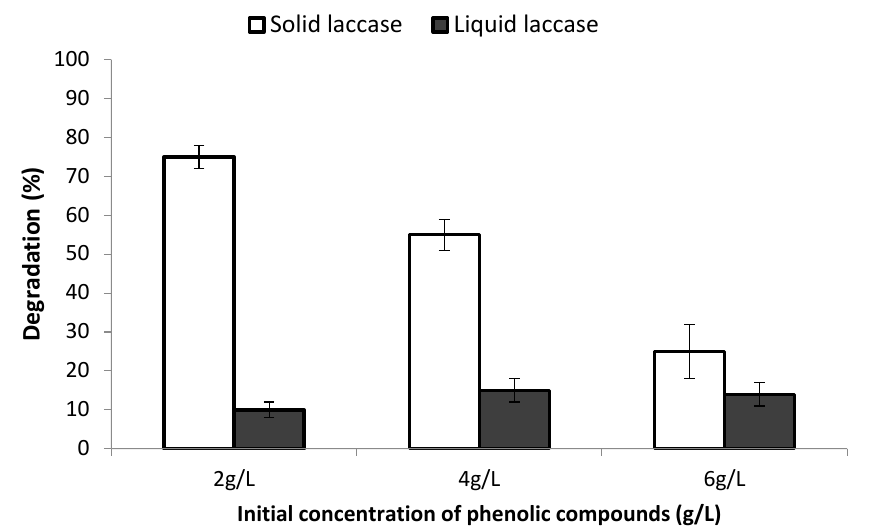
Figure 6. Degradation of the phenolic compounds by laccase enzymes as a function of the initial concentration of phenolic compounds.